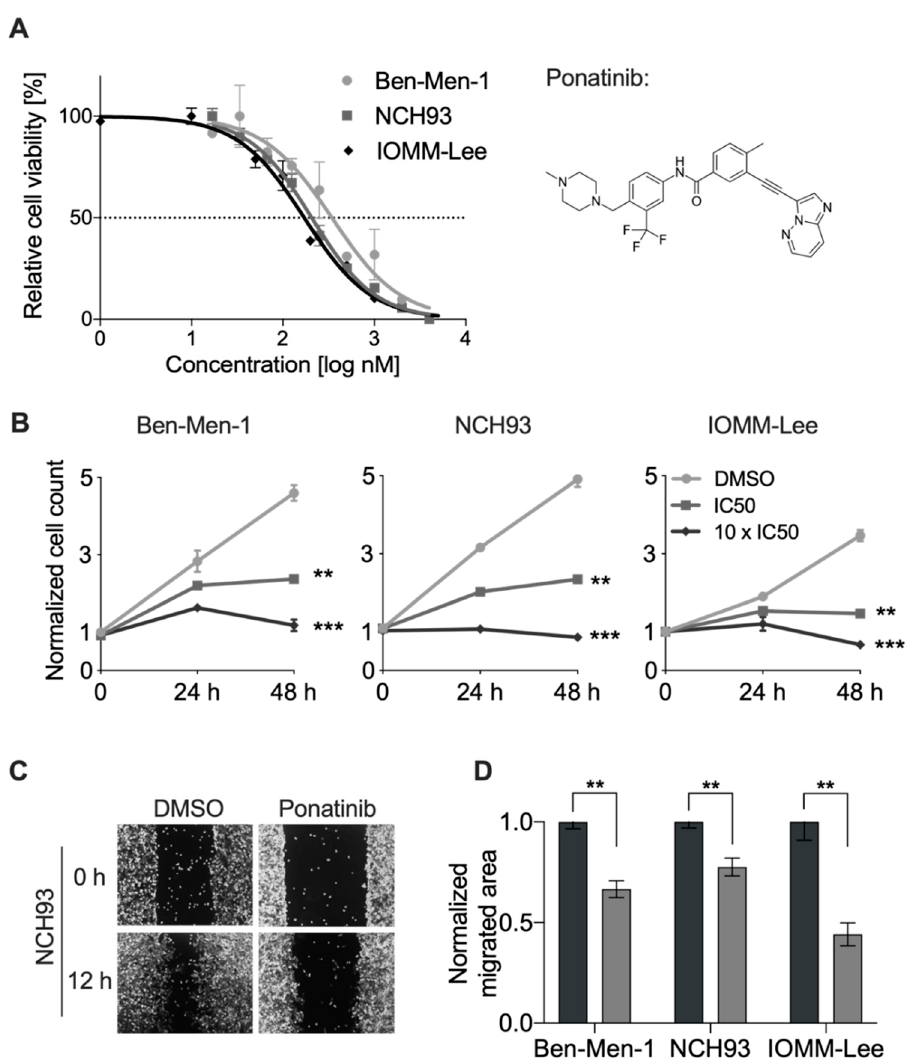
Figure 1. Ponatinib reduced meningioma cell proliferation and migration: ( A ) Illustrated are dose- curves of ponatinib in the benign meningioma cell line Ben-Men-1, and the malignant cell lines NCH93 and IOMM-Lee (left). The molecular structure of ponatinib is depicted (right). ( B ) Cells were treated with increasing concentrations (IC50 and 10 × IC50) of ponatinib or DMSO followed by a manual counting at 0 h, 24 h, and 48 h. ( C ) Wound healing assay using NCH93 cells showed delayed closure of the wound gap upon ponatinib treatment. ( D ) Quantification of the extent of the wound closure after 12 h. Each experiment was performed in triplicate and repeated three times. Results are expressed as mean ± SEM. ** p < 0.01; *** p < 0.001.